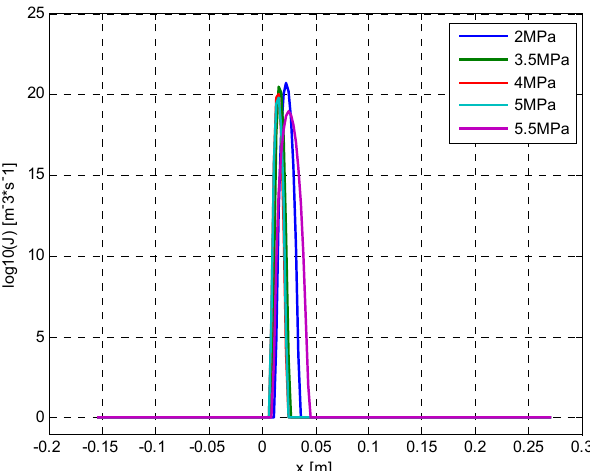
Figure 16. Nucleation rate curves along the axial cross-section of the supersonic separator at inlet pressure values 2, 3.5, 4, 5, and 5.5 MPa.